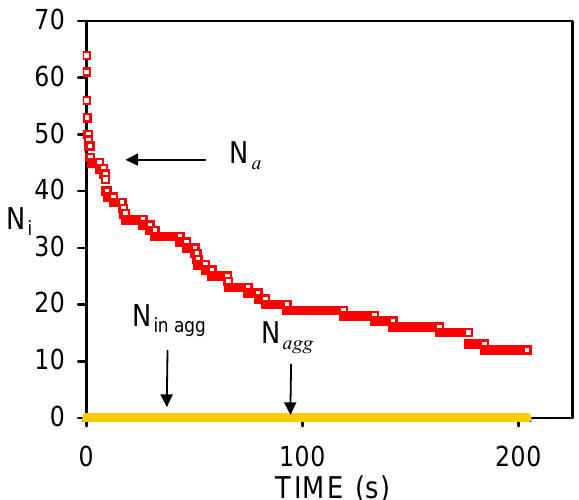
Figure 8. Behavior of system #12 from Refs. [19,73-74]. The subscripts are the same of = 4.10 x 10 -5 M, , A = 1.24 x 10 -19 Figure 3. ( φ = 0.16, C s H